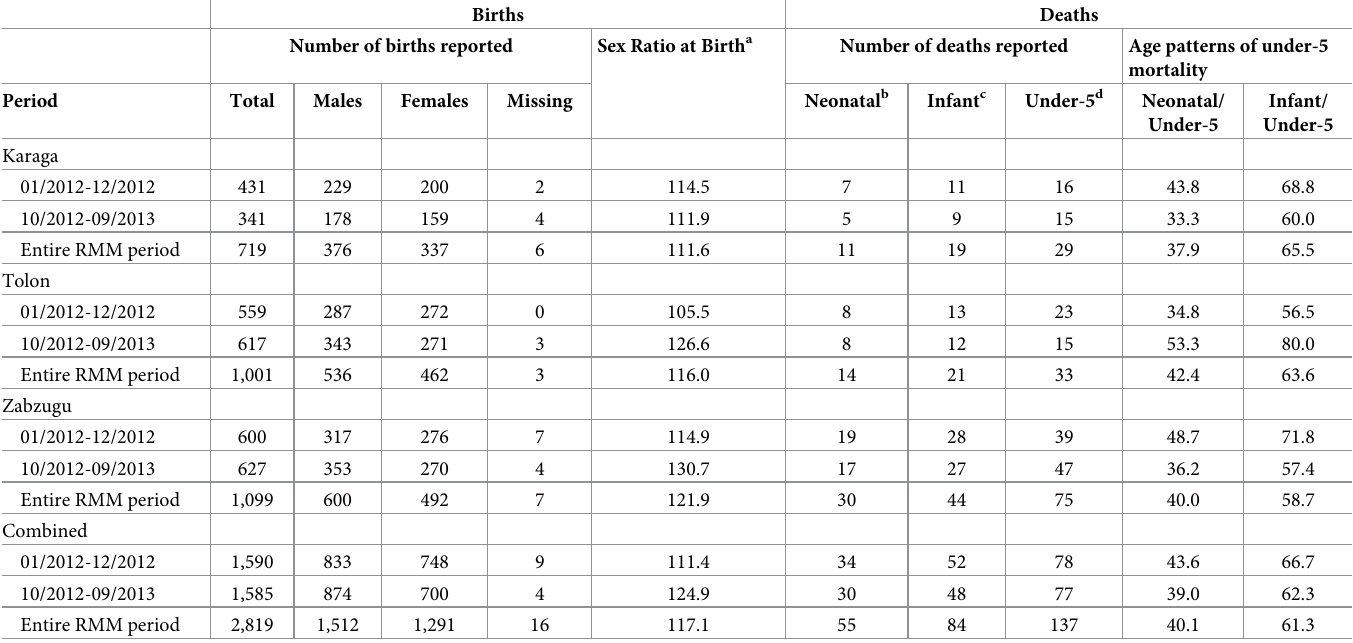
Table 2. Assessments of the quality of CBV data, by district and study